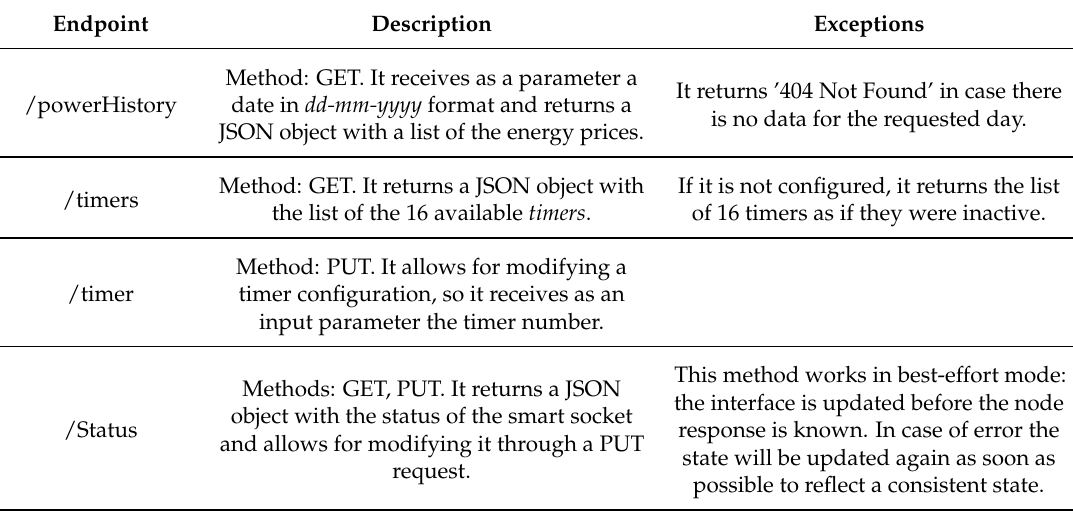
Table 2. REST API